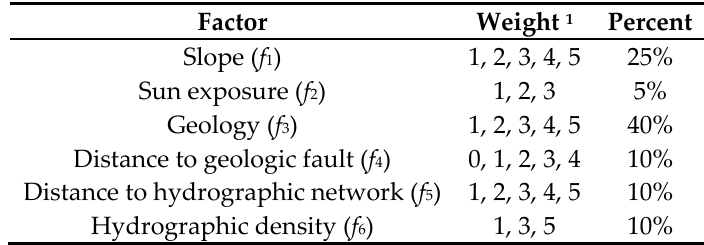
Table 1. Weighting of conditioning factors for landslides.